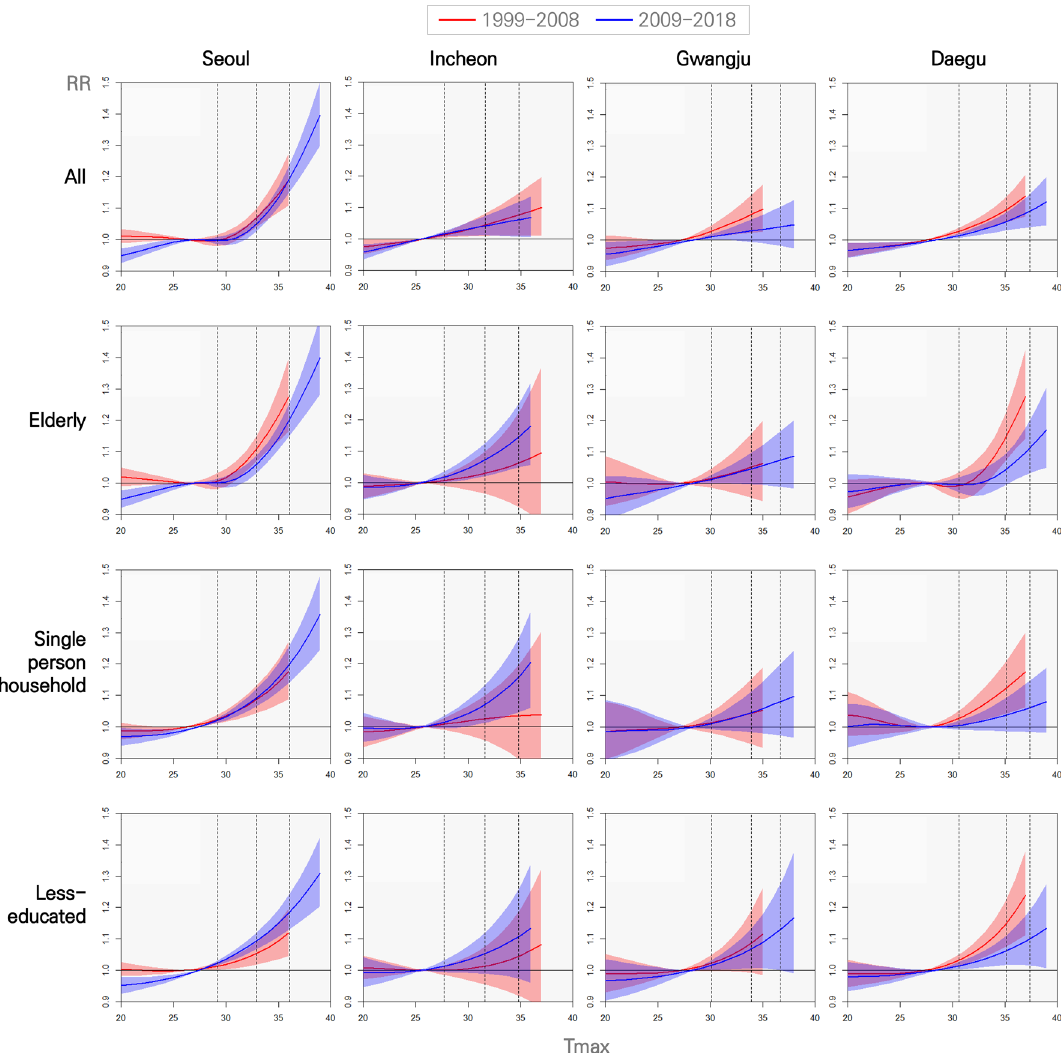
Figure 2. Comparison of associations between Tmax and mortality depending on vulnerable groups in the past and recent. The three vertical dotted lines indicate the 60, 90, and 99 percentile Tmax lines,